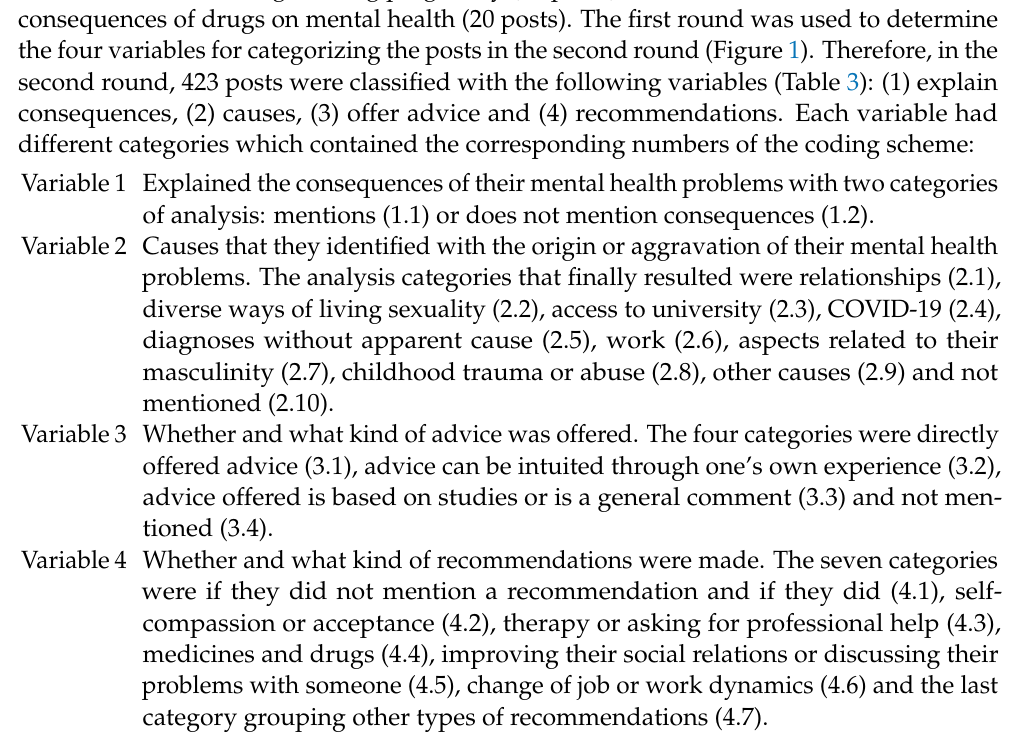
Table 3. Coding scheme and number of posts for each category and variable (second round). Variable